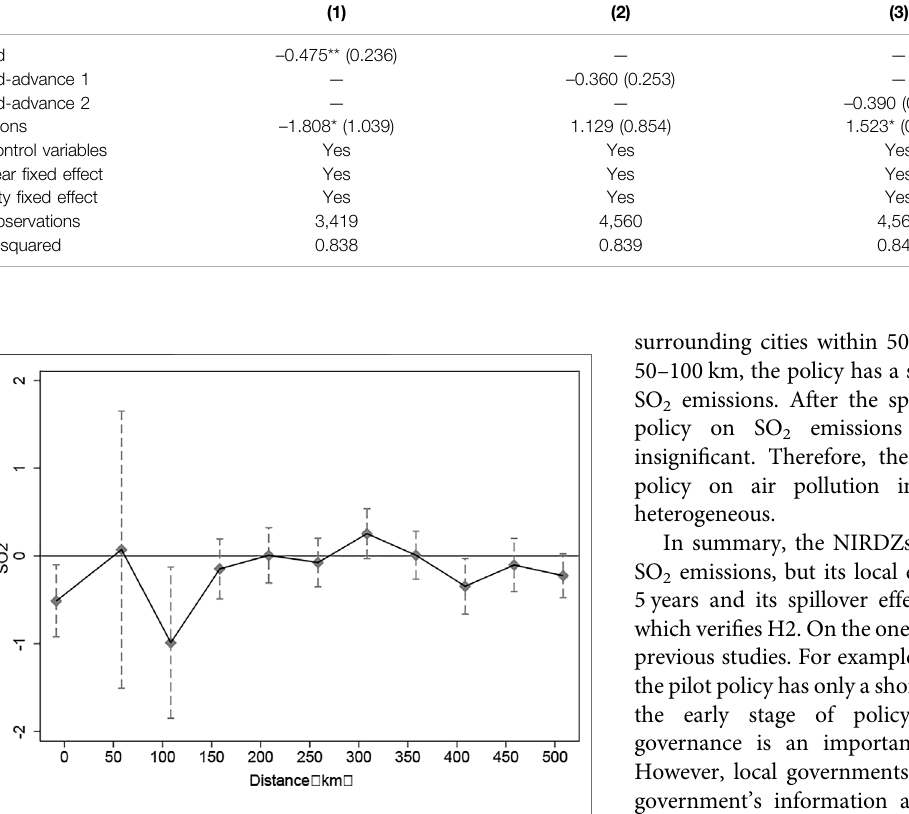
FIGURE 2 | Spatial